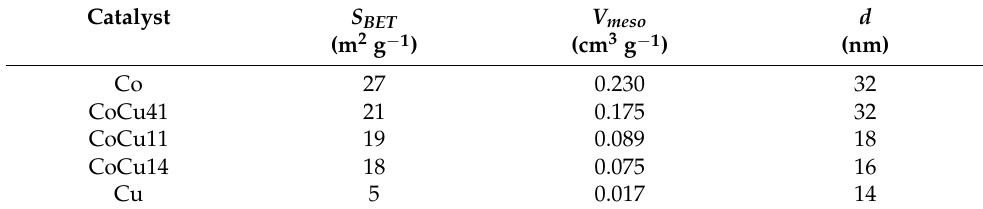
Table 3. Textural properties of the Co-Cu oxide catalysts determined from nitrogen adsorption ( S BET surface area, V meso pore volume of mesopores, d average pore